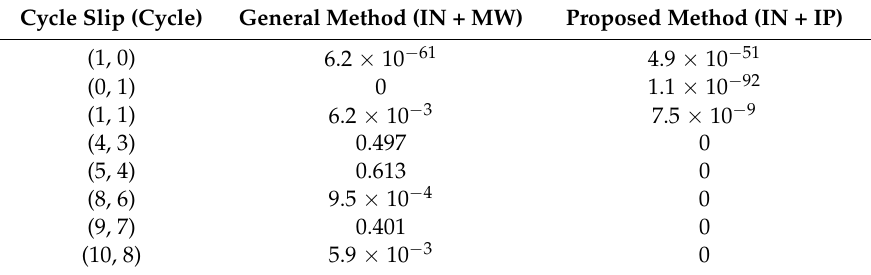
Table 3. Comparison results of the probability of missed detection (any probability less than 10 − 100 is entered as zero in the